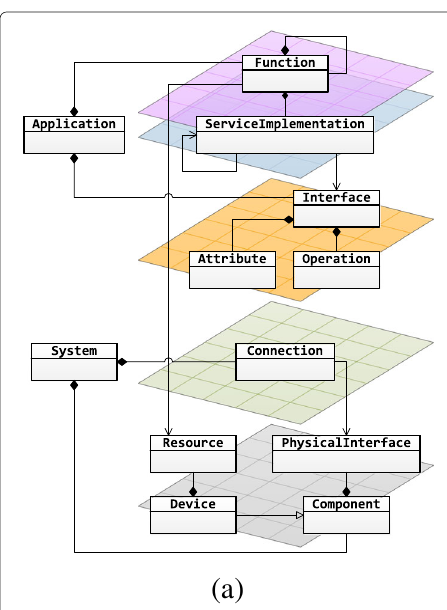
Fig. 4 Overview of PSAL: ( a ) UML representation, ( b ) sample code (Pröstl Andrén et al. 2017)